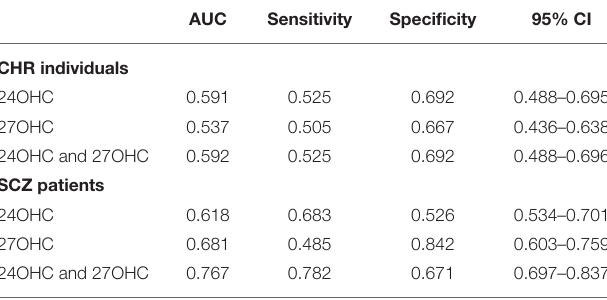
TABLE 4 | ROC curve analysis of oxysterols in CHR participants and schizophrenia patients. AUC Sensitivity